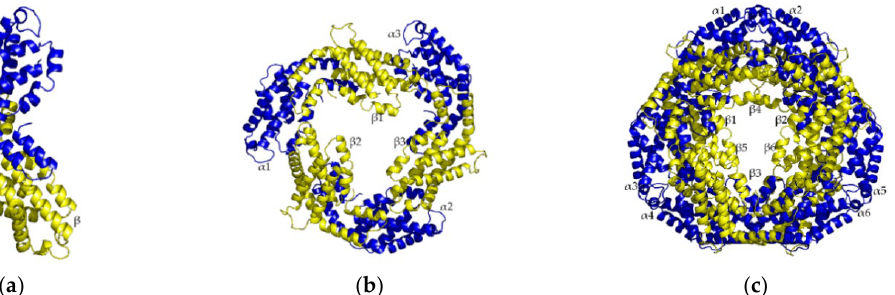
Figure 2. AlphaFold2 structure predictions of C − PC complex from S. platensis .; ( a ) C − PC monomer, ( b ) C − PC trimer, ( c ) C − PC hexamer. α subunits were marked in blue and β subunits were marked in yellow.